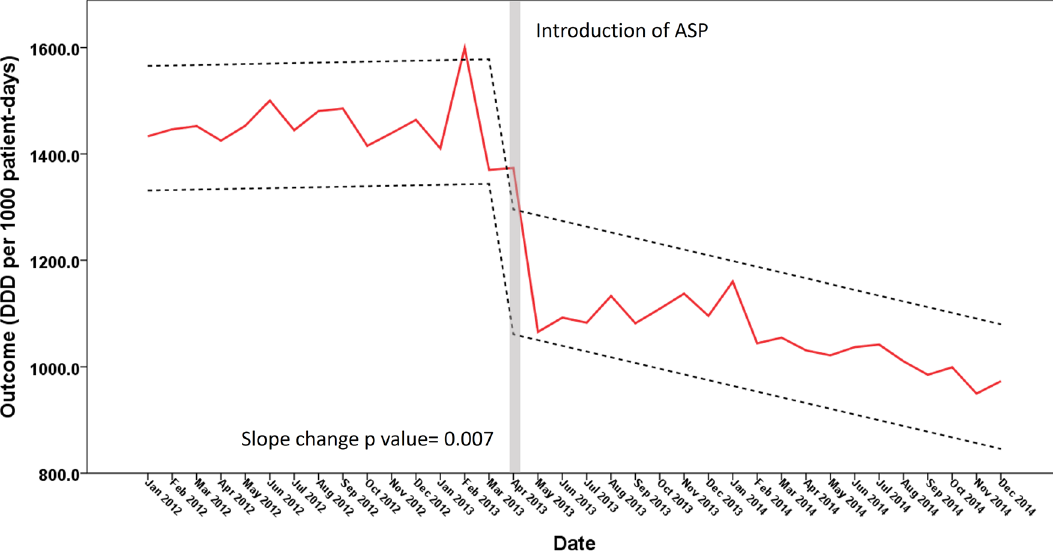
Figure 6. Interrupted time-series analysis of the impact of antimicrobial stewardship program implantation on antimicrobial consumption of antibiotics. Slope and level change model is used. Refer to “Material and methods” for detail. p value for slope change model is 0.007. Red solid line: predicted trend based on regression model. Black dash lines: upper and lower control